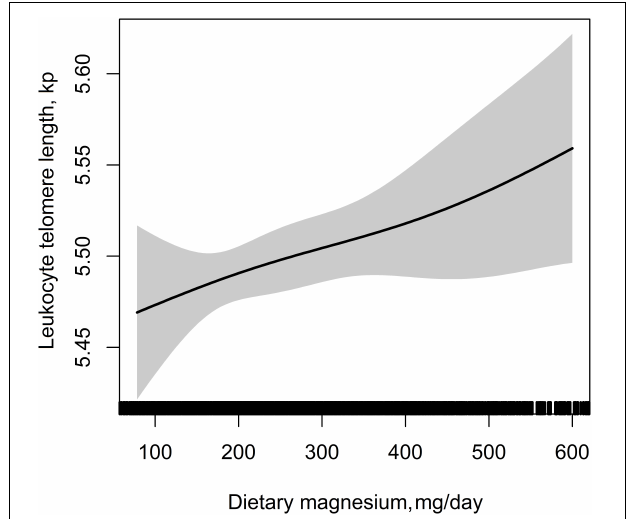
FIGURE 3 | Dose–response relationship between dietary magnesium intake and leukocyte telomere length. Adjusted for age, sex, BMI, race, education status, smoking status, alcohol consumption, physical activity, PIR, hypertension, diabetes, TC, TG, HDL-C, FBG, sample weight, dietary fiber, and total energy